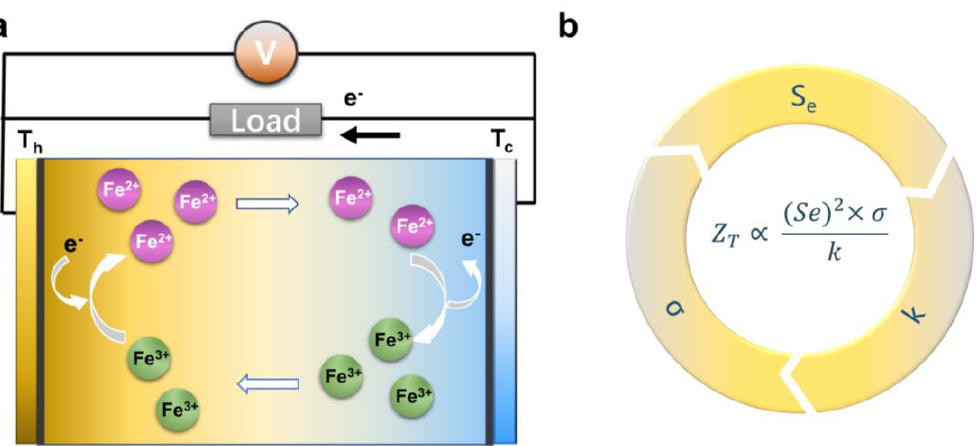
Figure 2. ( a ) Thermogalvanic working principle. ( b ) Influencing factors of thermoelectric figure of merit ZT.